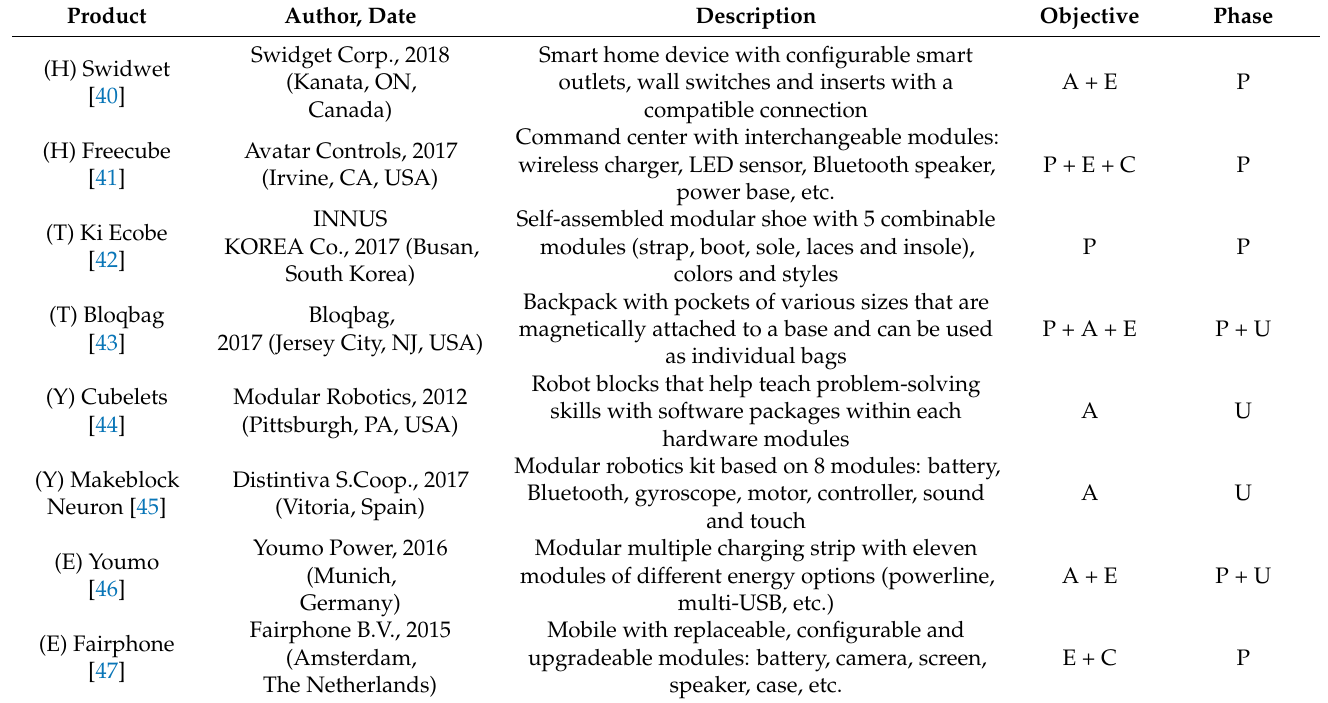
Table 1. Modular design real cases for prosumer.